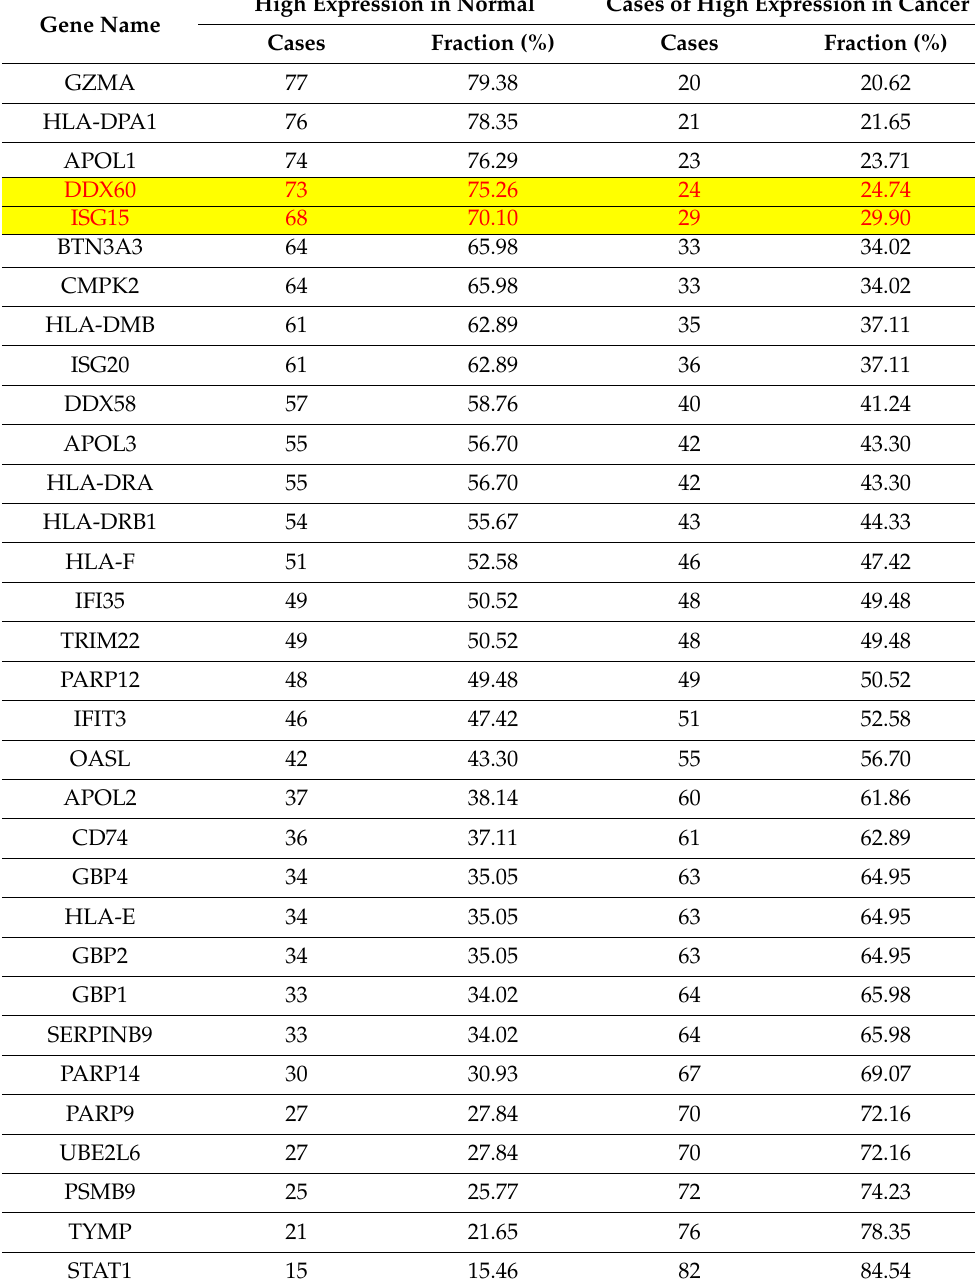
Table 1. The different fractions between normal tissues and cancerous tissues (from the Proteogenomic Analysis of Human Colon Cancer Study [38] for the 35 potential candidates correlated with MHC-I and IFN- γ expression. The genes highlighted in yellow are the final